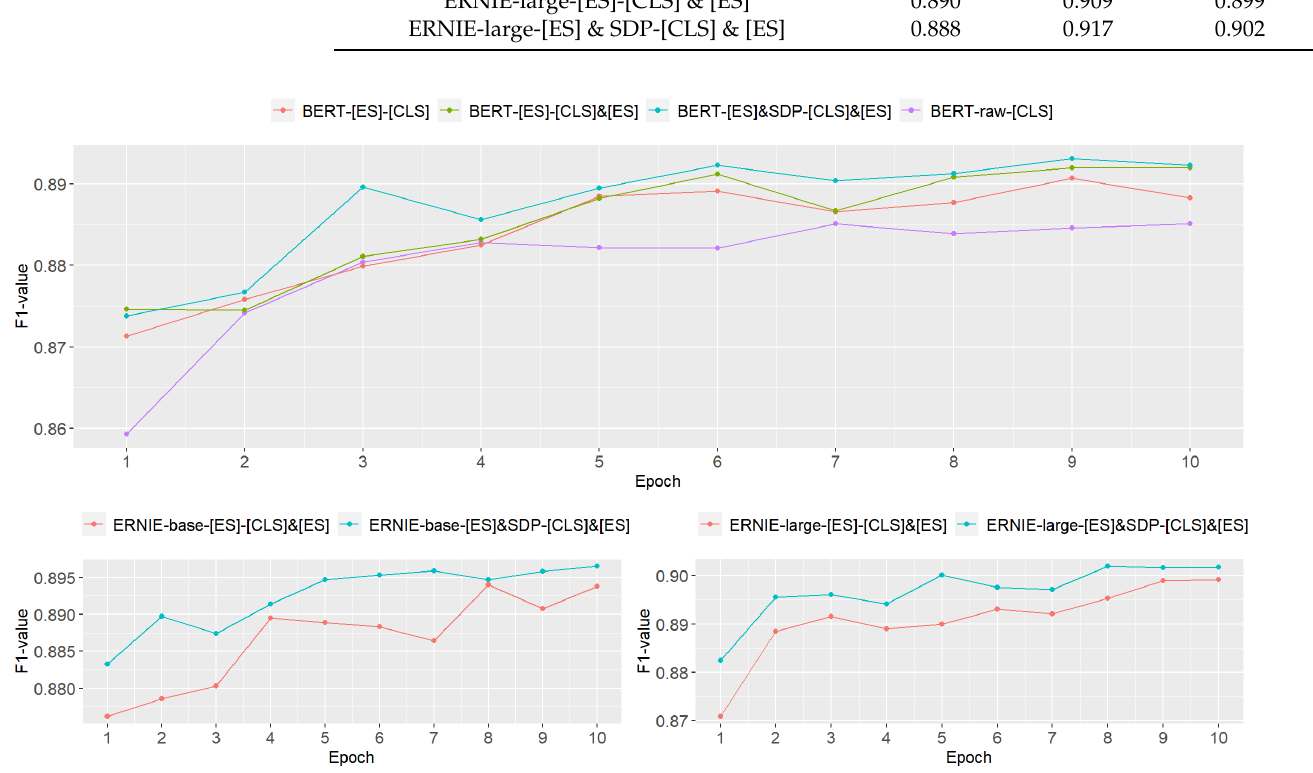
Figure 10. The F1 values of the ablation experiment at each training